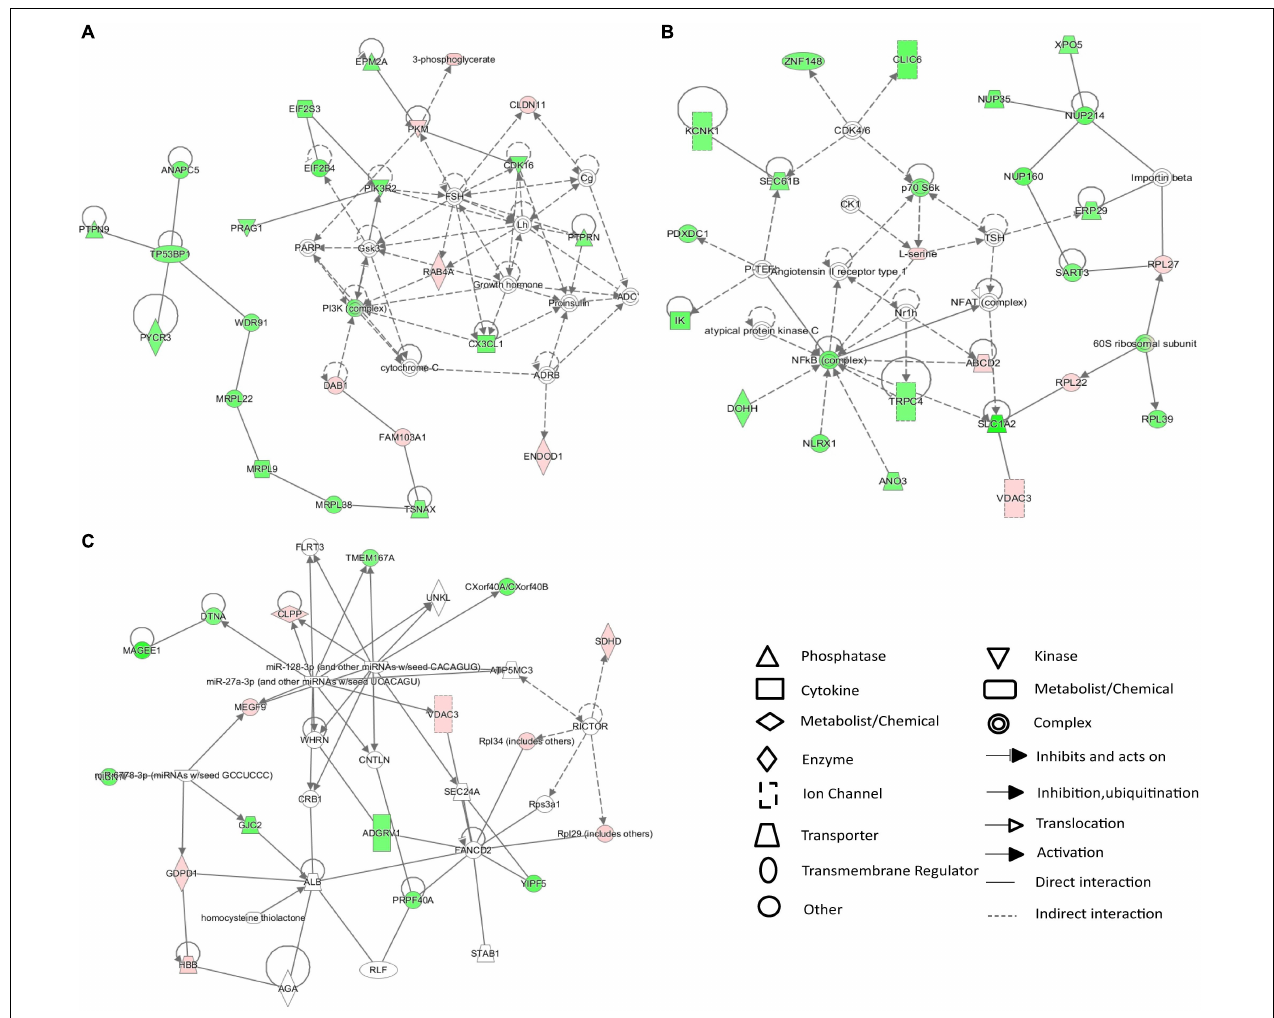
FIGURE 4 | IPA network analysis of differentially expressed proteins and metabolites in the CSDS model group. (A–C) Top-ranked enriched networks based on changed products. Red, significantly increased; green, significantly